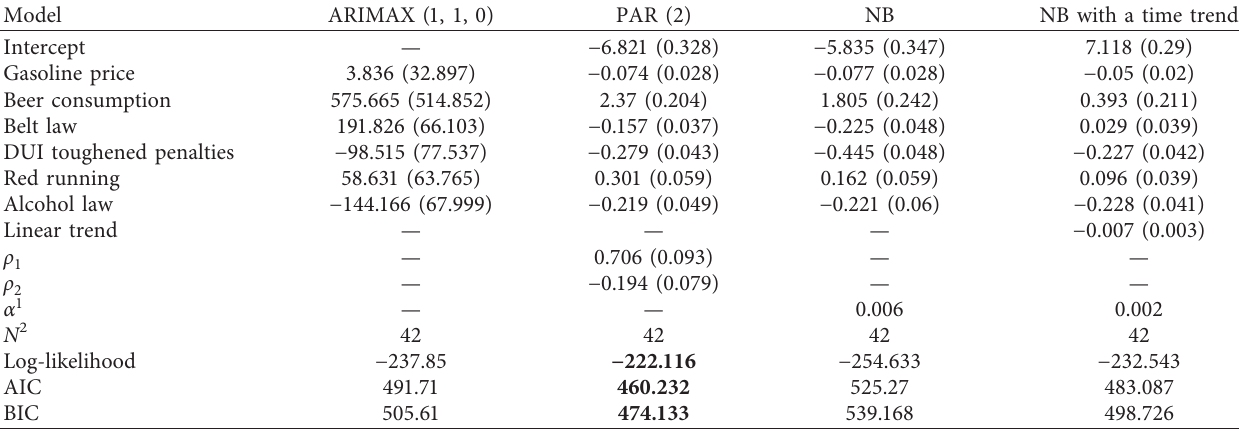
Table 3: Fatal traffic accident analysis (standard errors in